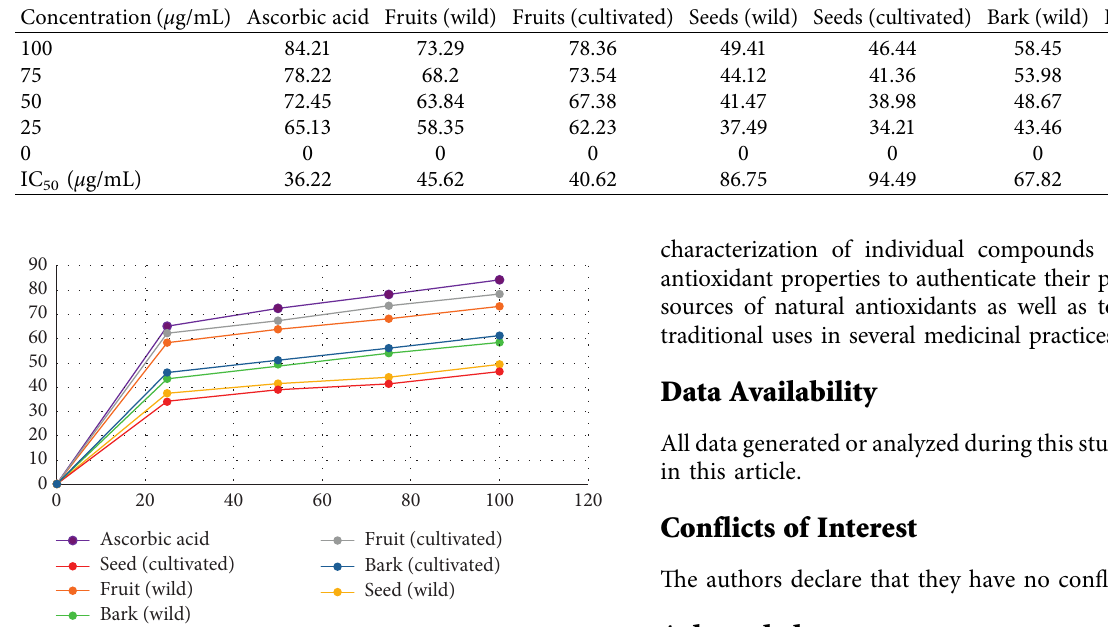
Figure 1: Plot of radical scavenging percentage between ascorbic acid and different samples.